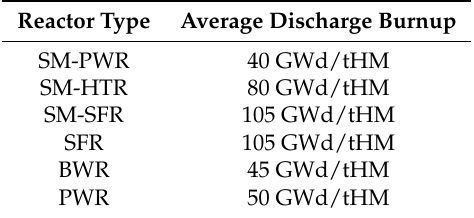
Table 3. Average discharge burnup for each reactor type considered in the scenarios